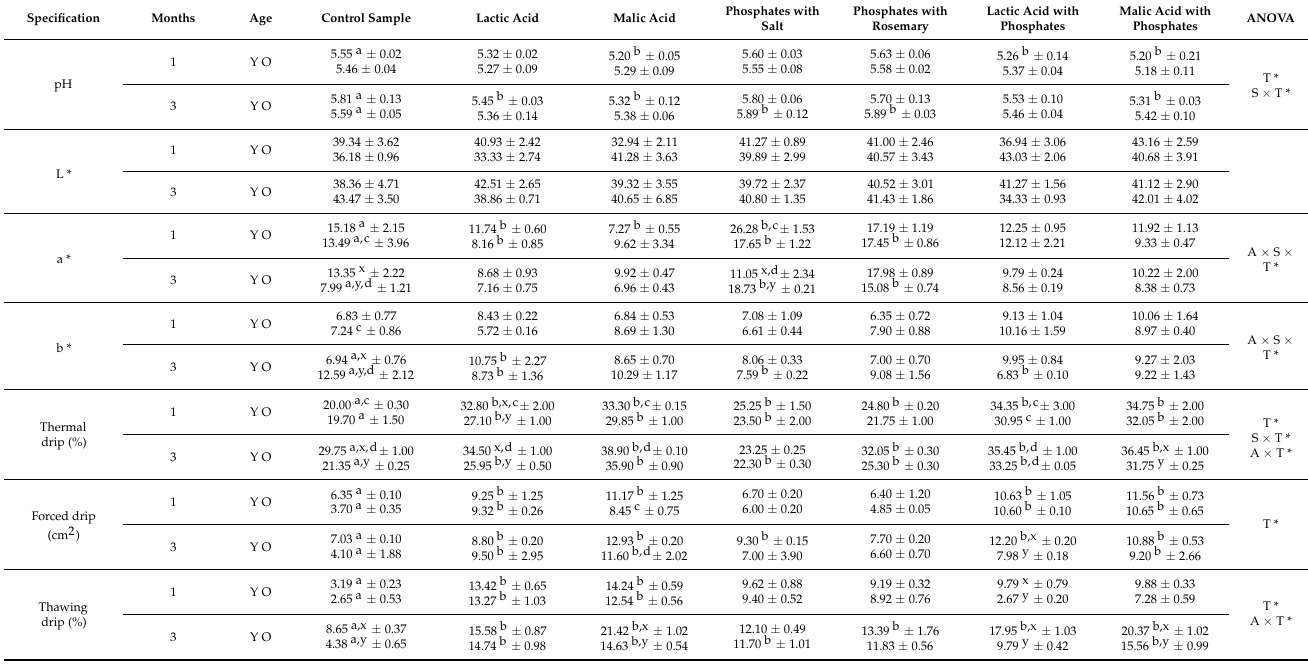
Notes: a,b different letters in the same row indicate statistically significant differences between the control sample and the samples marinated with selected substances ( p < 0.05). x,y Different letters in the same column indicate statistically significant differences between the age groups of horses in particular periods of frozen storage ( p < 0.05). c,d Different letters in the same column indicate statistically significant differences between the periods of frozen storage in particular age groups of horses ( p < 0.05). ANOVA, three-way ANOVA; S, selected substances; A; age of animal; T, time of storage. * p < 0.05. Y and O denote younger and older horses,